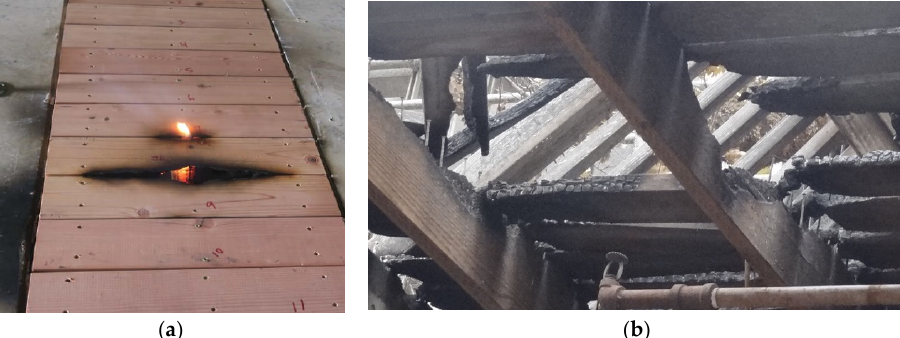
Figure 11. ( a ) Fire propagation along the joist towards the test building ( b ) Fire propagation along the joist towards the main building in a commercial wine-tasting room in Napa Valley, California, during the 2020 Glass Fire. (Images taken during IBHS’s post-event investigation).